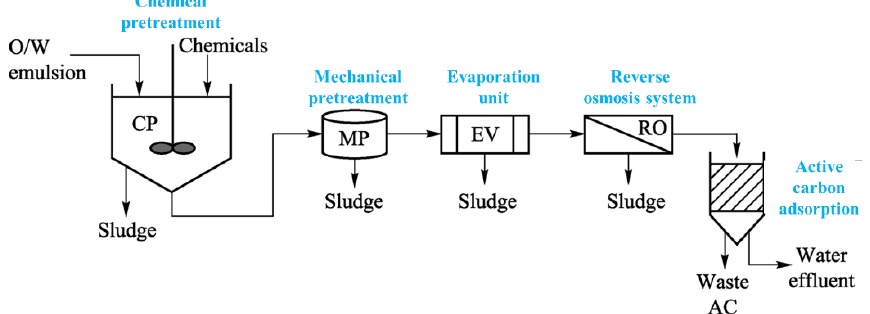
Figure 13. Schematic of the integrated process for O/W emulsions treatment [193]. Reproduced with permission from Z.N. Pintarič, et al., 2016 (ref. [ 193]). Copyright 2016, Higher Education Press and Springer-Verlag Berlin Heidelberg.